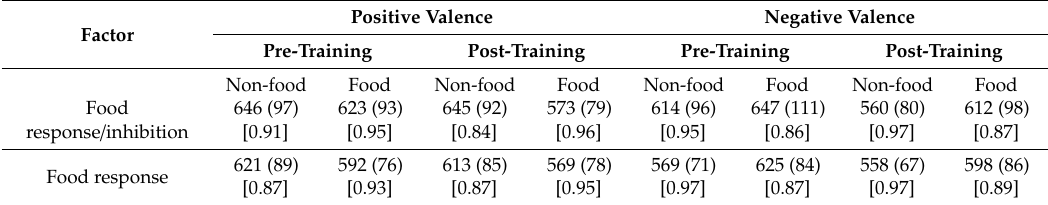
Table 2. Results of Experiment 2—food–valence compatibility task